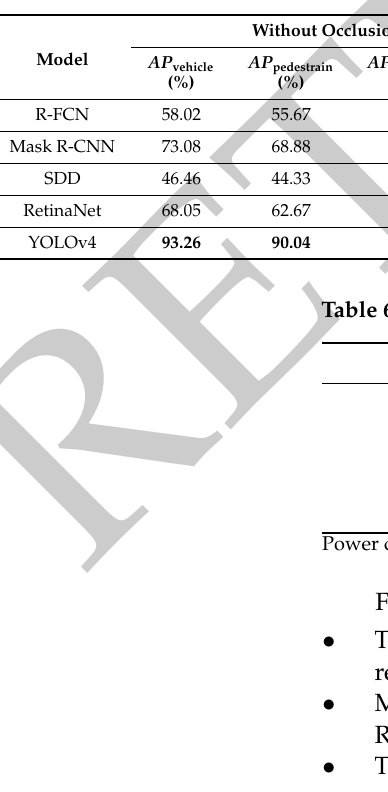
Figure 11. Precision-Recall (PR) curve of object detection models with occlusion and truncation on BDD100K dataset. Table 5. Detection Accuracy of Object Detect Models on BDD100K dataset.